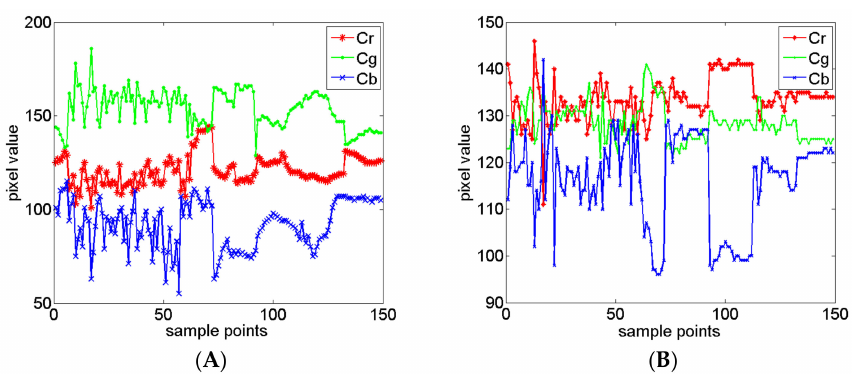
Figure 4. Values of the Cr, Cg and Cb components for ( A ) rice seedling and ( B ) background sampling